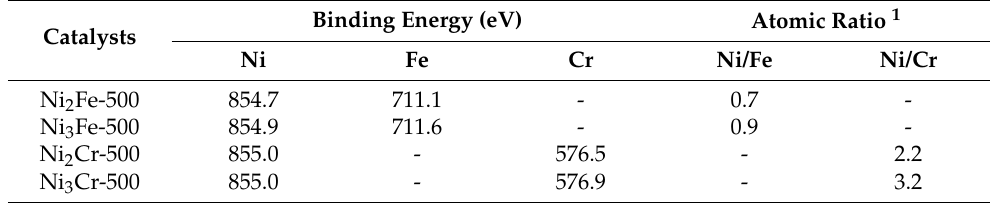
Table 4. Binding energy (eV) and Ni/M atomic ratios (M = Fe or Cr) obtained by XPS. Binding Energy (eV) Catalysts